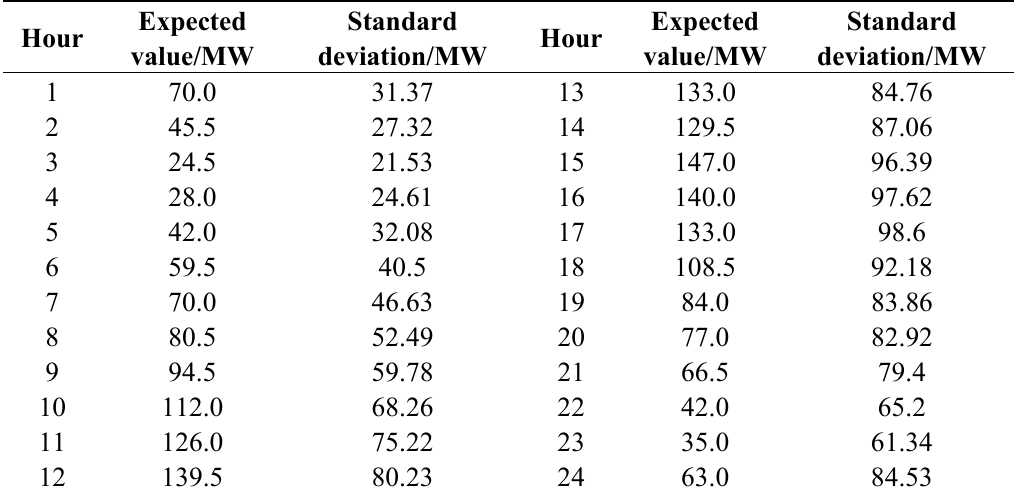
Table 2. Hourly expected value and standard deviation of day-ahead wind power forecast.